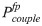
Suppression of intrinsic fluctuations in FB and IFF architectures.A. Cartoon representation of direct feedback regulation architecture. B, C. Suppression of inherent stochastic fluctuation in FB architecture. Shown is the coefficient of variation (cv) as a function of the effective gain αfb. (B) Direct regulation (green line) can completely suppress the fluctuations for high enough gains. The coupled implementations (red line) can reduce the cv, but such reductions are moderate and best for small gains. The decoupled implementation always increases the cv. Shown are also the penalty terms Pcouplefp, Pproxyfp. Parameters used: y¯=50, x¯=50. Shown are FSP solutions (black dots) for implementations with f(u) = 50, l1 = 1, l2 = 1g(x)=111+10(x/50)h, h = 0, 1, …, 10). (C) The benefits of coupled implementation (red lines) and the penalties of the decoupled implementation (blue lines) are reduced as x¯ increases (compared to y¯). Shown is cv for y¯=50, x¯=5,50,100. D, E. Suppression of inherent stochastic fluctuation in IFF architecture. Shown is the cv as a function of the effective gain αff. (D) The coupled implementations (red line) can reduce the cv, but such reductions are moderate and best for small gains. The decoupled implementation always increases the cv. Parameters used y¯=50, x¯=50. Shown are FSP solutions (black dots) for implementations with f(u) = 50, k1 = 1, and k2 and k12 as shown in Table A in S1 Text. (E) The benefits of coupled implementation (red lines) and the penalties of the decoupled implementation (blue lines) are reduced as x¯ increases. Shown is cv for y¯=50, x¯=5,50,100. F, G. Comparison of FB and IFF architectures. For the same gains, FB coupled implementation (solid red line) performs slightly better than the IFF counterpart (dotted red line), and the FB decoupled implementation (solid blue line) performs slightly worse than the IFF couterpart (dotted blue line). Such differences are emphasized for smaller x¯. Shown are implementations with y¯=50,x¯=50 (panel E) and y¯=50,x¯=10 (panel F).